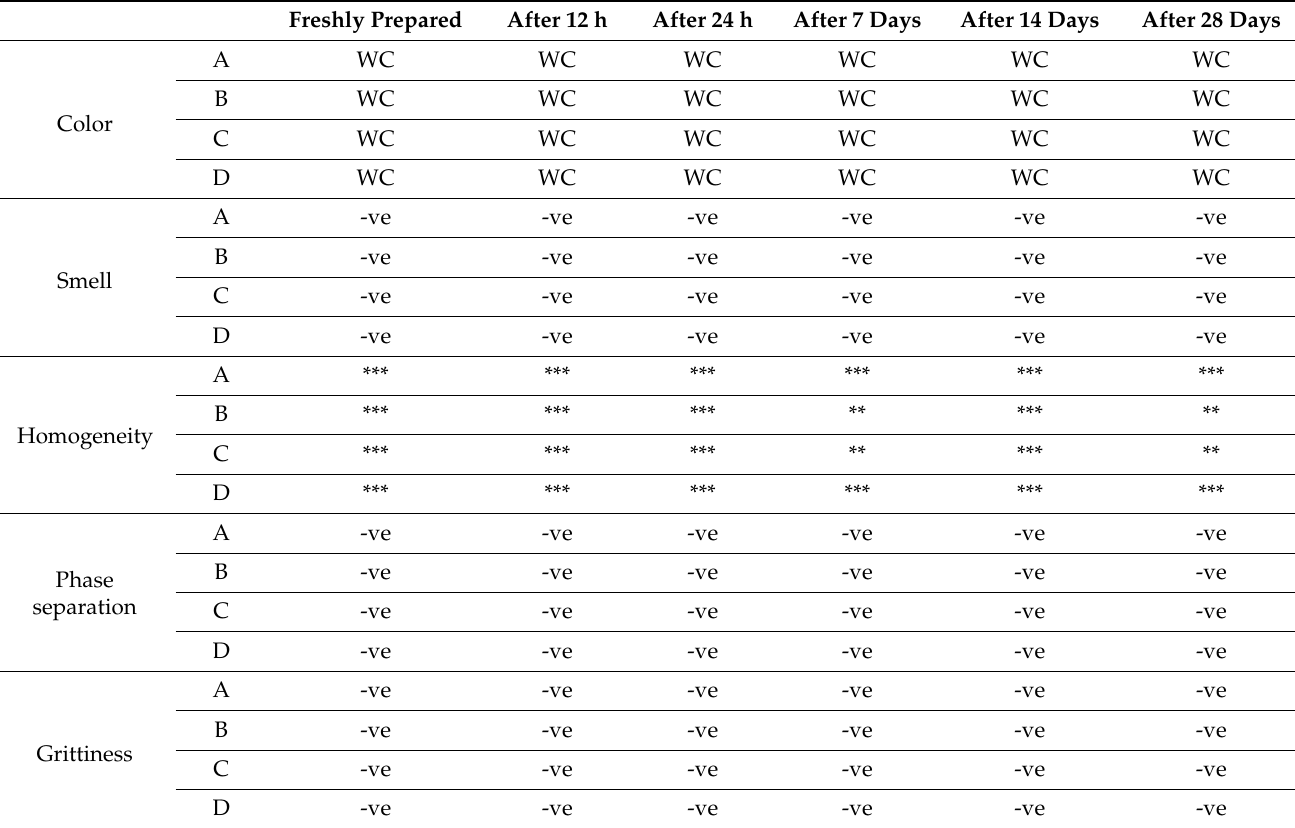
Table 1. Physical properties of eugenol–linalool emulgel